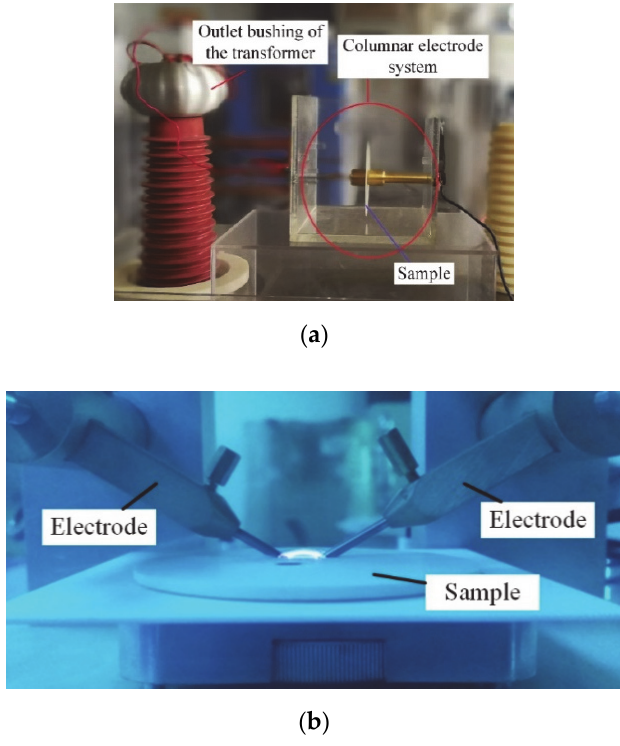
Figure 2. Photo of the breakdown system and the arrangement in arc ablation resistance test: ( a ) breakdown system; ( b ) arrangement in arc ablation resistance test.